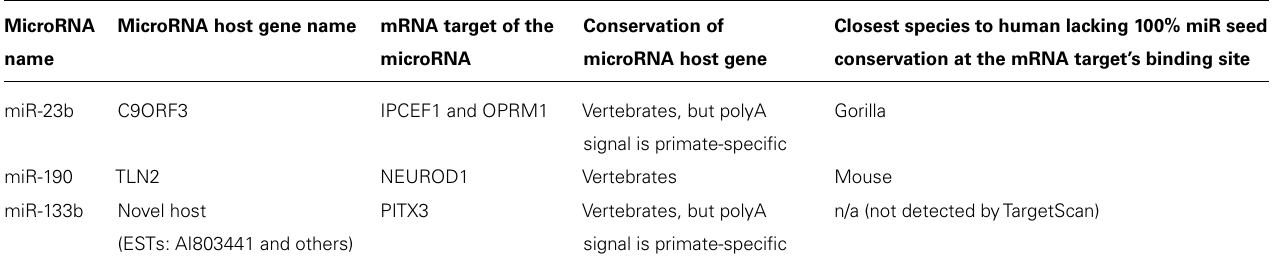
Table 2 | MicroRNAs and morphine: function and conservation − Seed sequence, host gene, and target binding site conservation of microRNAs with known opioid abuse functions, as assessed by viewing the corresponding microRNA host genes and their mRNA targets within the genome-wide 46-species MultiZ alignment in the human UCSC Genome